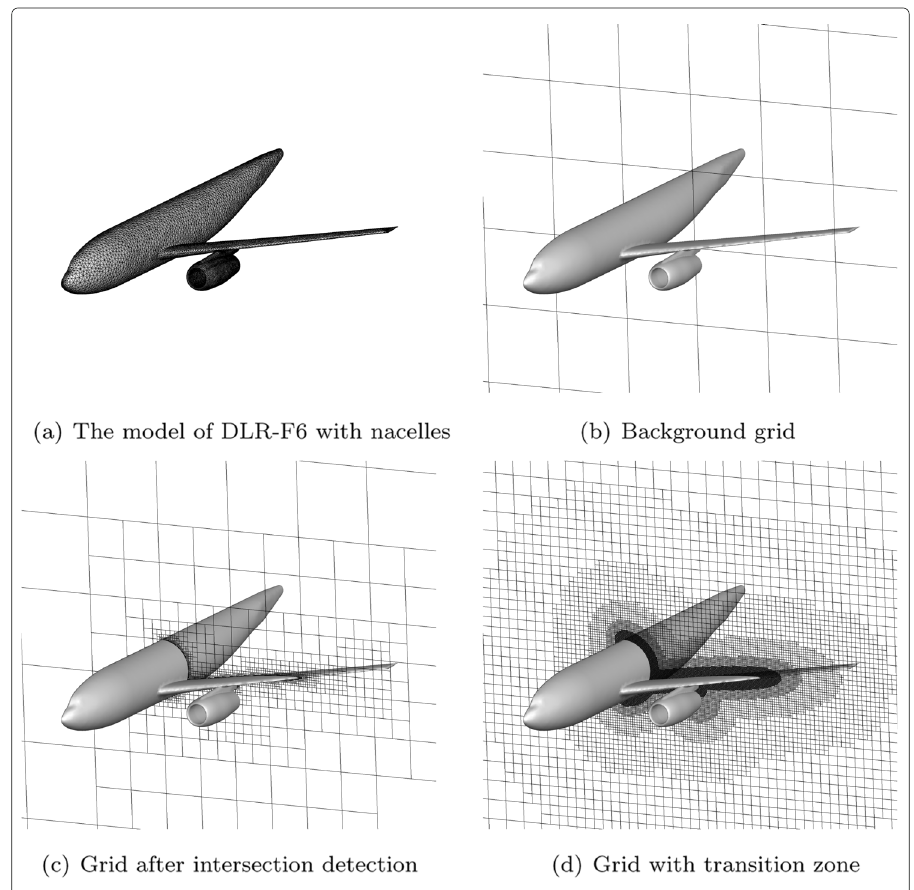
Fig. 3 The changes of the grid during the generation process of DLR-F6